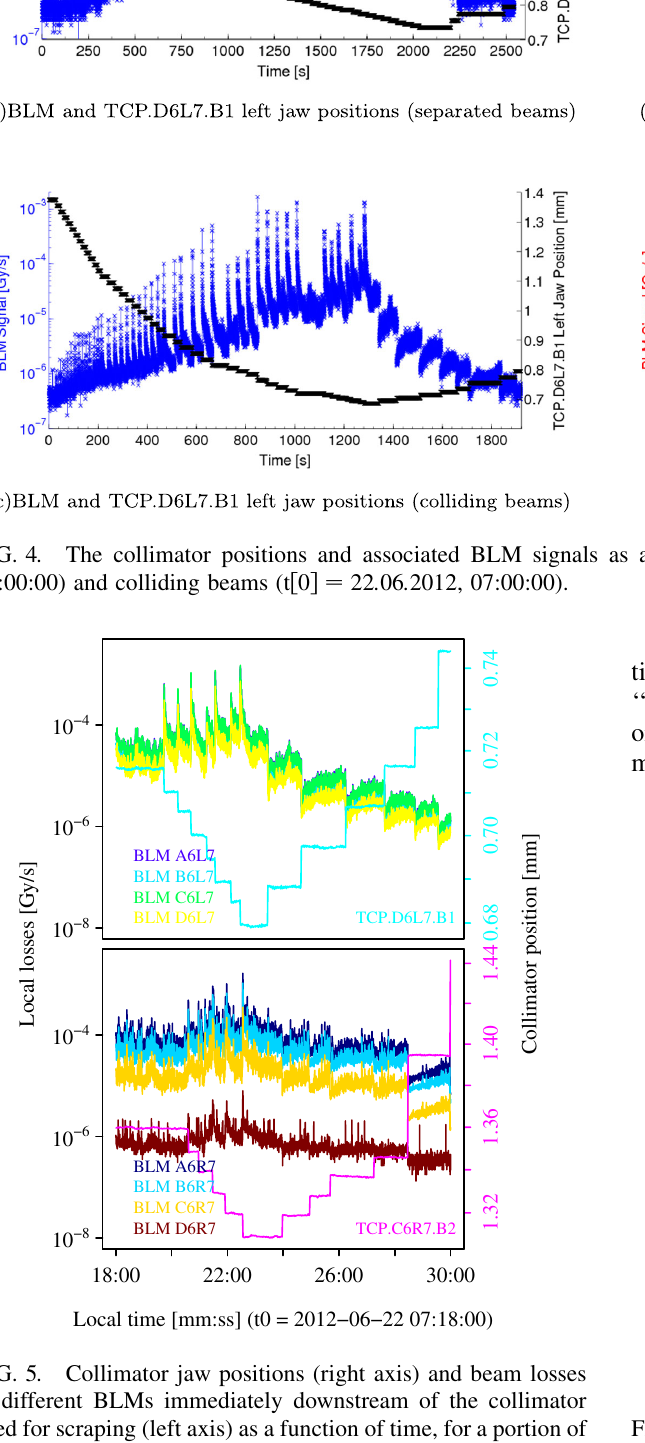
FIG. 6. Local loss monitor calibration as a function of colli- mator